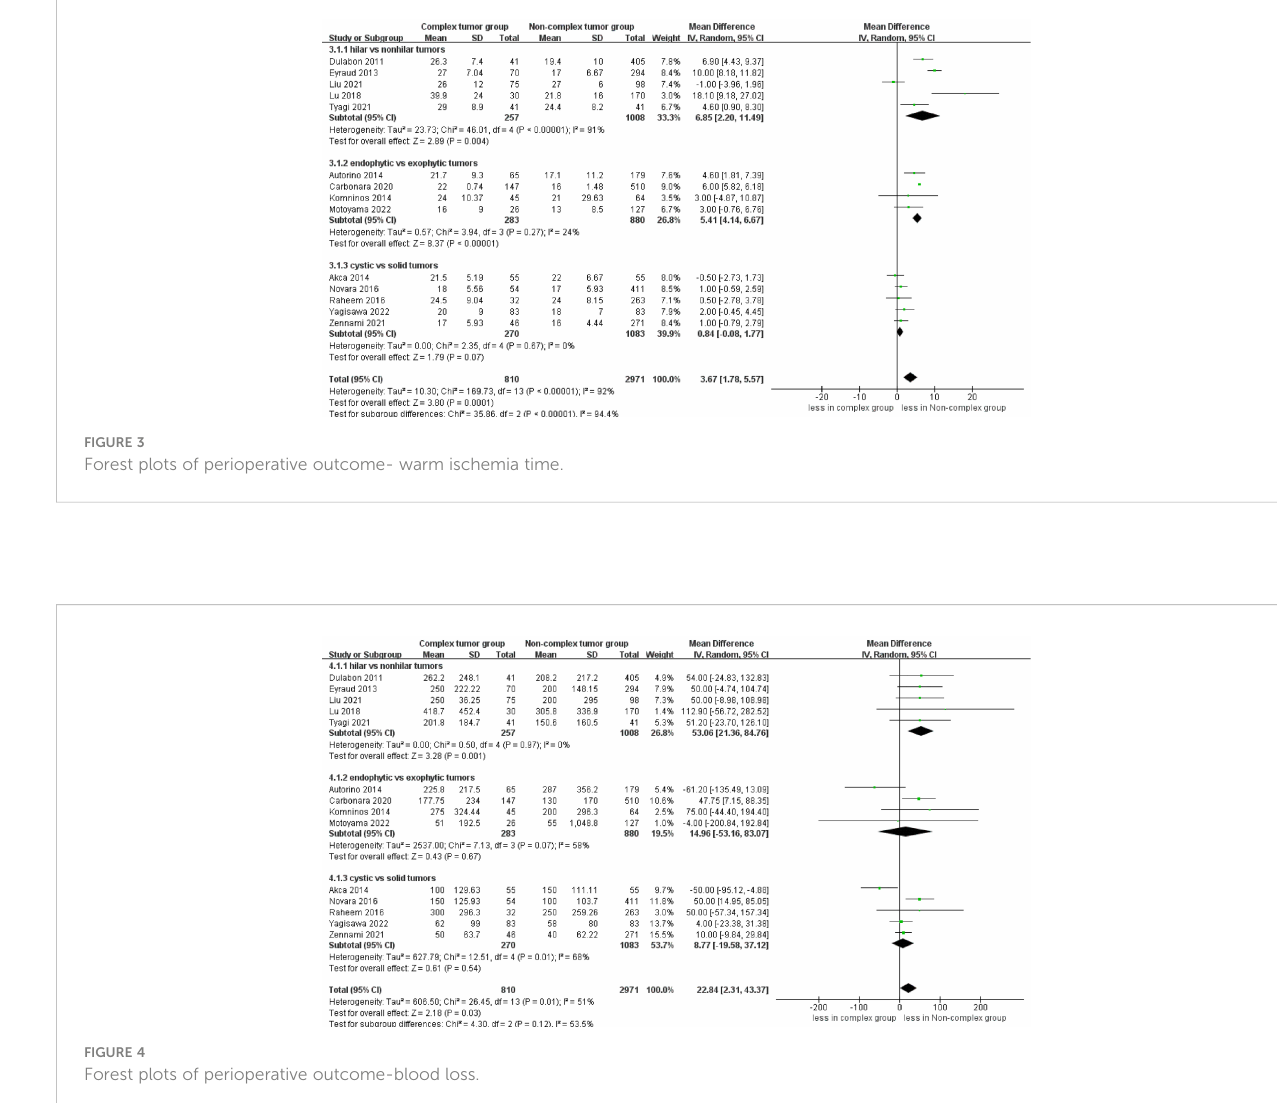
FIGURE 4 Forest plots of perioperative outcome-blood